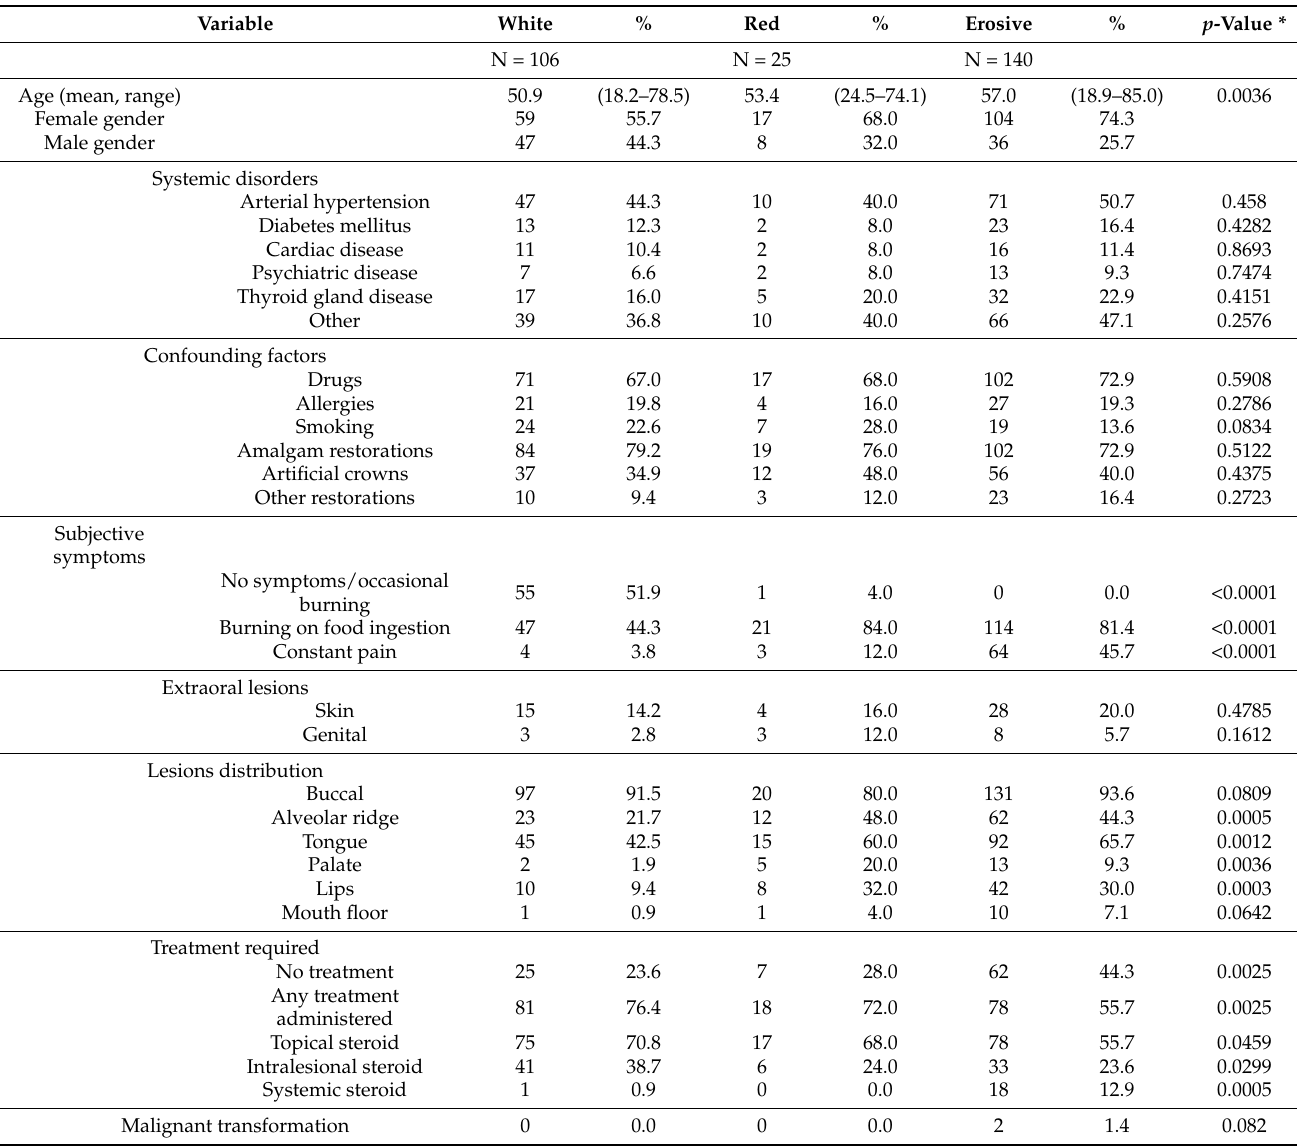
Table 2. Comparison of subgroups of